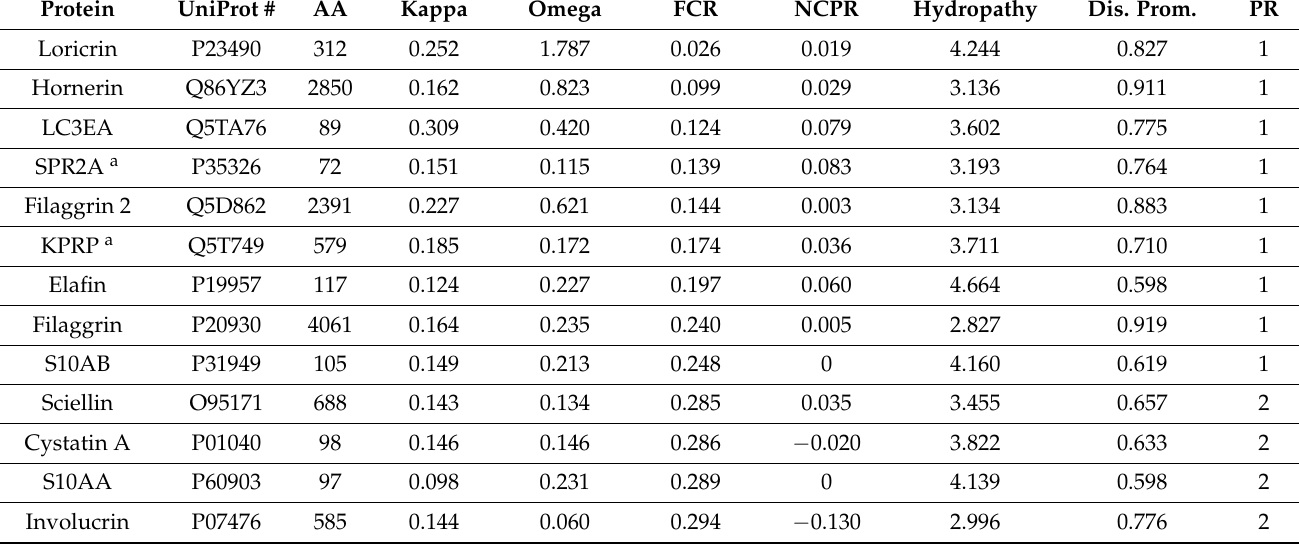
PR, CIDER plot region, see Figure 7. SPR2A, Small proline-rich protein 2A. LC3EA, Late cornified envelope protein 3A. KPRP, Keratinocyte proline-rich protein.